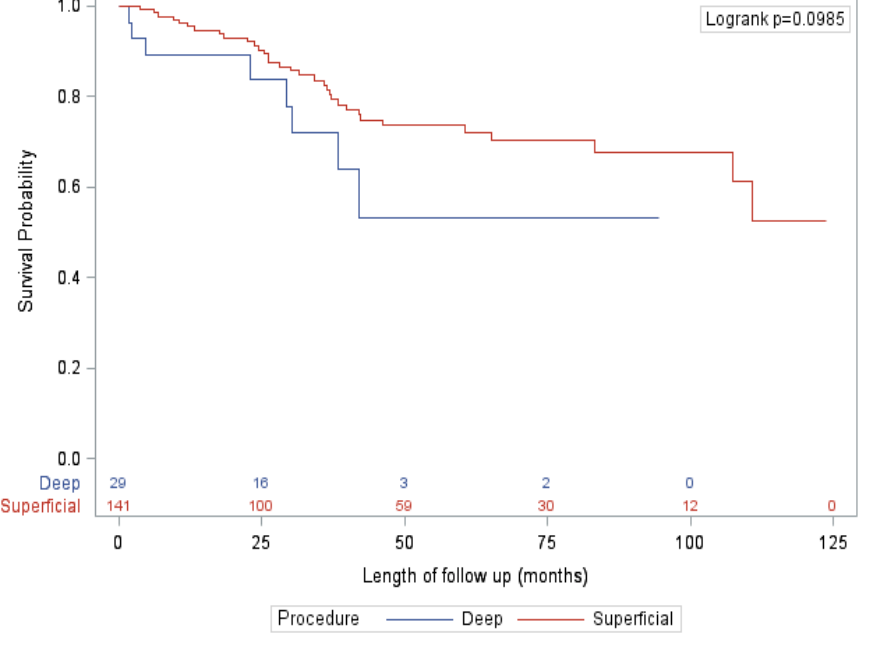
Figure 1. Overall survival—SLNB subgroup.